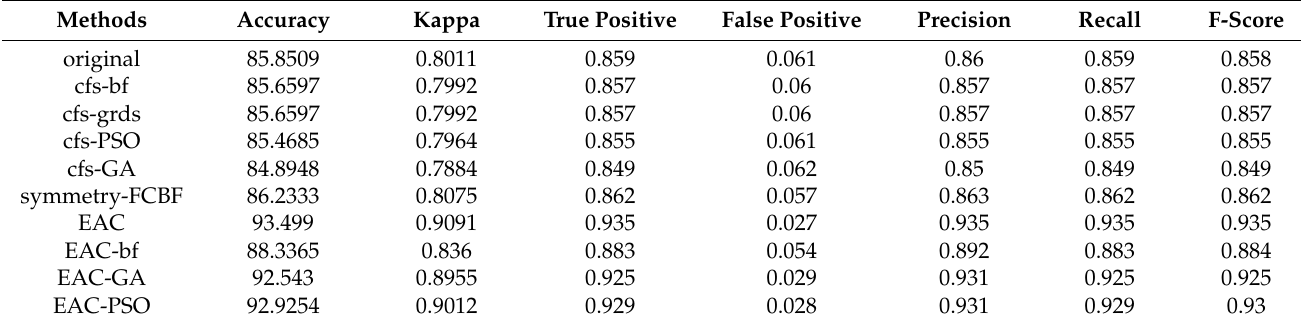
Table 5. Comparison of performance of traditional decision tree model coupled with ten preprocessing algorithms.